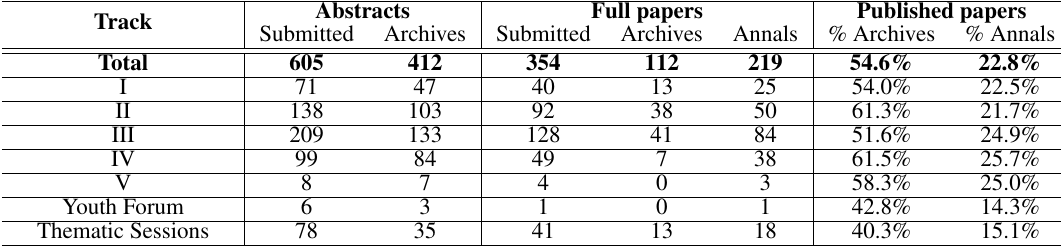
Table 2. Detailed statistics for each